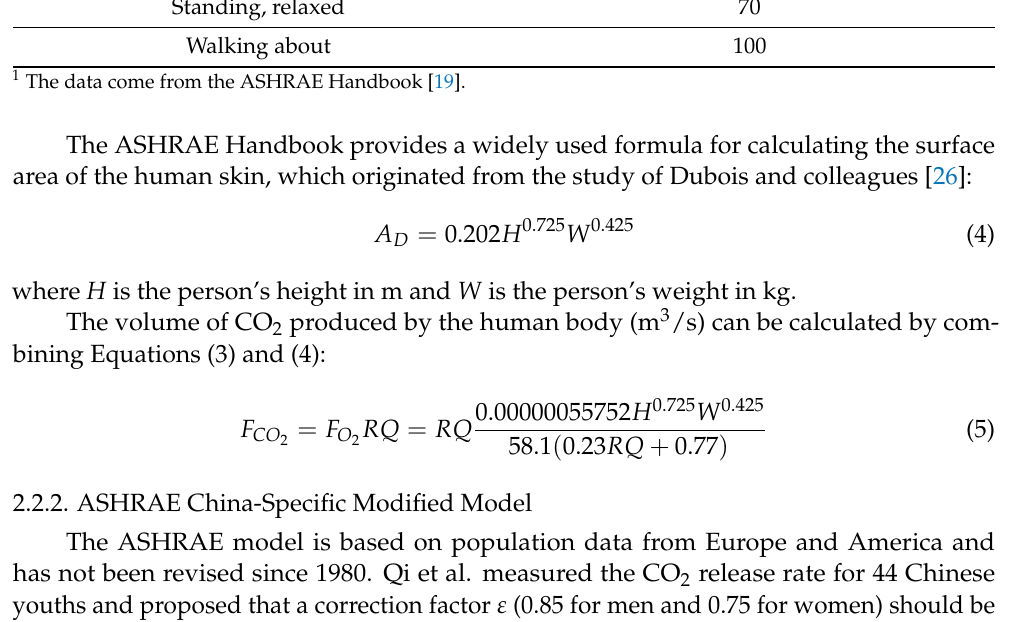
Table 1. Typical metabolic heat generation for various activities. Activity Sleeping 40 Reading, seated 55 Typing, seated